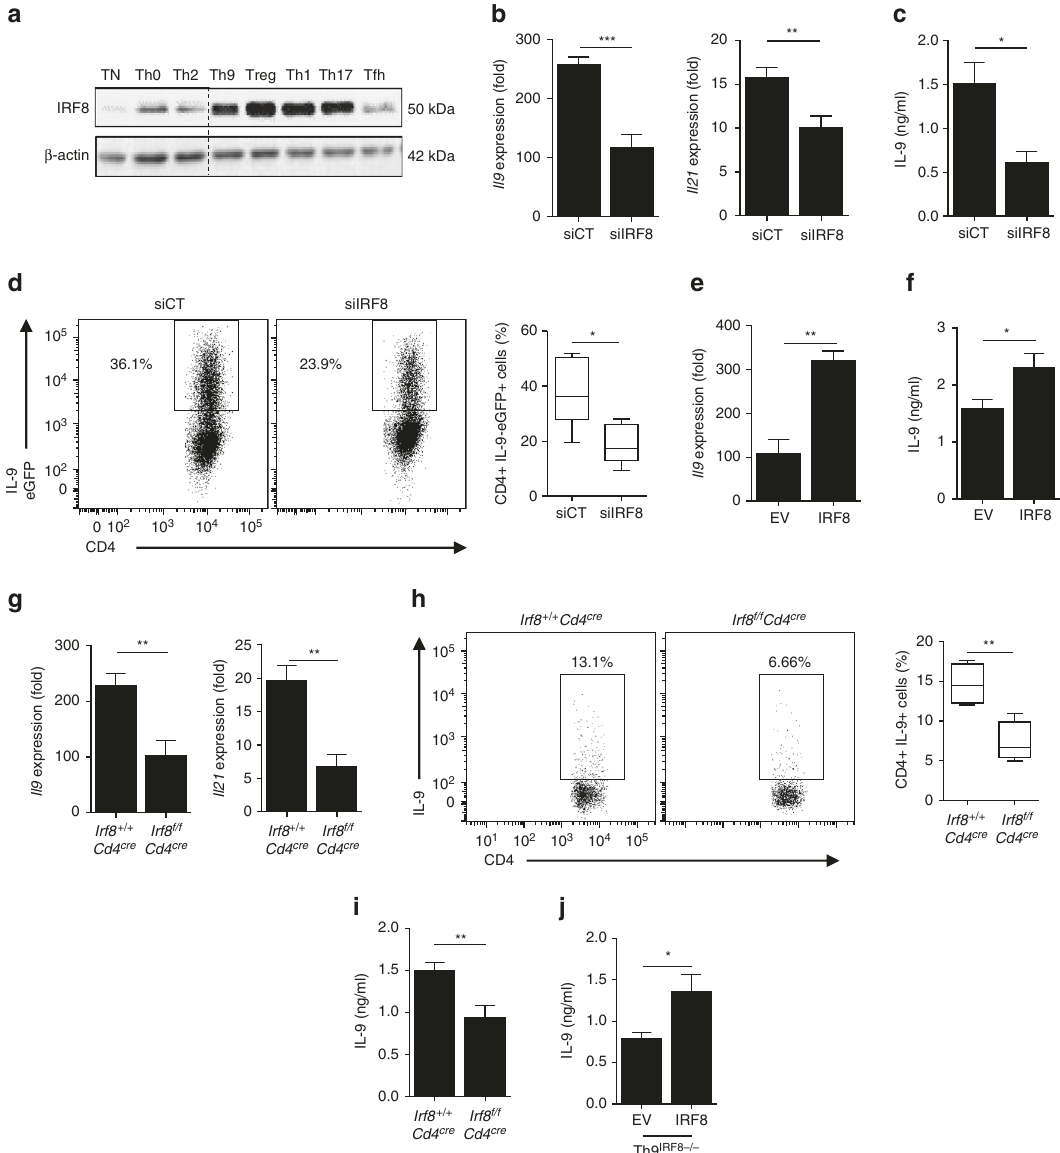
Fig. 1 IRF8 de fi ciency impairs Th9 cell development in vitro. a Immunoblot analysis of IRF8 in WT naive CD4 + T cells or after 1 day of differentiation into Th0, Th2, Th9, Treg, Th1, Th17 and Tfh cells. b , c WT naive CD4 + T cells were transfected with control siRNA (siCT) or siRNA against Irf8 (siIRF8), and then polarised under Th9 conditions. Relative expression of Il9 and Il21 mRNA ( b ) ELISA analysis of IL-9 protein in supernatant ( c ). d IL-9-eGFP naive CD4 + T cells were transfected with siCT or siIRF8, and then polarised under Th9 conditions. After 3 days of differentiation, eGFP-positive cells were assessed by fl ow cytometry (left: representative dot plot, right: means of four independent experiments). e , f WT naive CD4 + T cells were retrovirally infected with an empty- GFP vector (EV) or IRF8-GFP overexpressing vector (IRF8). GFP + cells were sorted 2 days after infection and differentiated for 3 days into Th9 cells. Il9 mRNA expression e and IL-9 protein release assessed with ELISA ( f ) were evaluated. g - i , Irf8 f/f Cd4 cre and Irf8 + / + Cd4 cre CD4 + T cells were differentiated into Th9 cells for 3 days. Il9 and Il21 mRNA expression ( g ) ELISA analysis of IL-9 protein in supernatant ( h ) and IL-9 intracellular staining in Th9 cells ( i ) (left: representative dot plot, right: means of four independent experiments). j IRF8-de fi cient naive CD4 + T cells were retroviral infected with an empty-GFP vector (EV) or IRF8-GFP overexpressing vector (IRF8). GFP + cells were sorted 2 days after infection and differentiated for 3 days into Th9 cells. IL-9 protein release was evaluated by ELISA. ns, not signi fi cant; * P < 0.05, ** P < 0.01; *** P < 0.001 (Mann – Whitney test). Data are from three b , c , e – h or two j independent experiments (mean and s.e.m.), d , i and one experiment representative of four independent